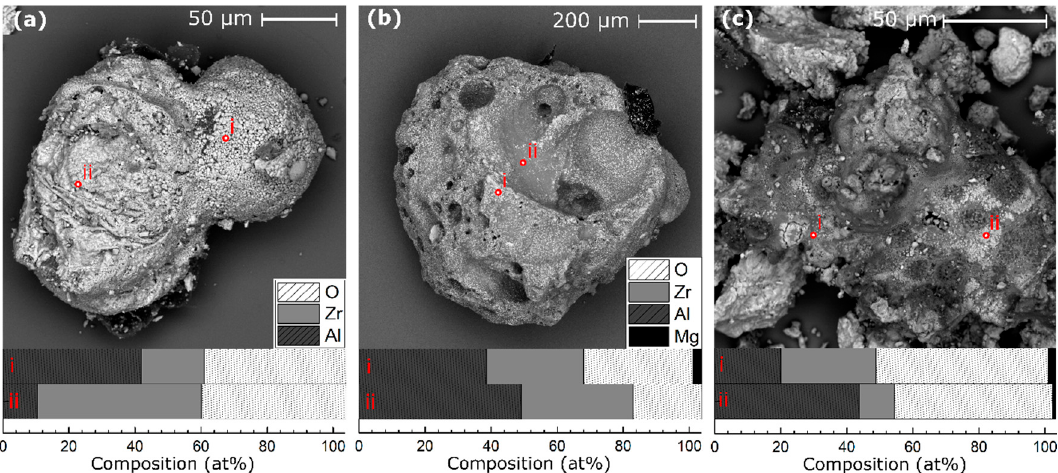
Figure 5. Representative backscatter SEM images of large sintered particles collected post-reaction from the bomb calorimeter crucible. ( a ) Al:Zr PVD 40 µm sintered particles; ( b ) Al–8Mg:Zr PVD 40 µm sintered particles; ( c ) Al–8Mg:Zr ball milled sintered particle(s).